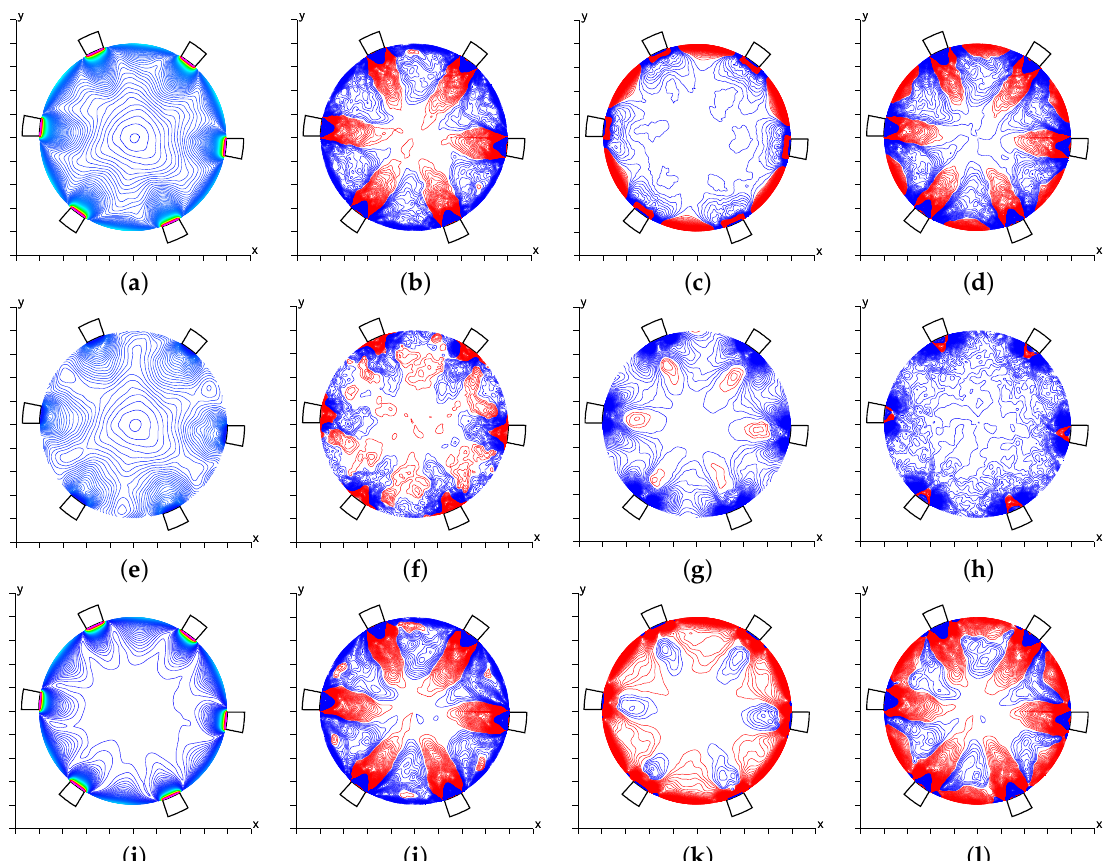
Figure 11. Contour plots of turbulence kinetic energy ( K + , panel a ), its incoherent contribution ( K + , panel e ); its incoherent contribution ( χ + , panel i ), for SLL corrugations, in increments ∆ + = 0.01, in a blue to red scale, up to K + = 5. In the second column (panels b , f , j ), we show the respective T K + C K + Π K budget terms, in the third column (panels c , g , k ), the P K + D K budget terms, and in the fourth column (panels d , h , l ) the sums of all terms. Positive contours are shown in red, and negative ones in blue, in ∆ + = 0.003